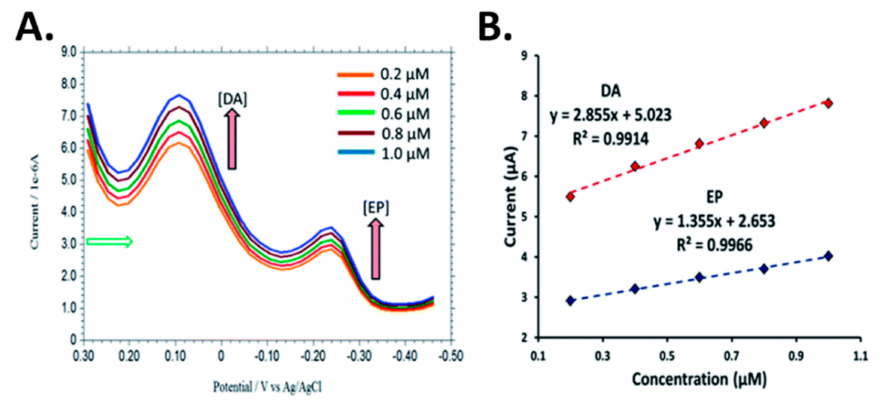
Figure 10. ( A ) DPV voltammograms of increasing concentrations of DA and EP in 0.1 M PBS at AgNPs-PCA-Au electrode. ( B ) Plot of current as a function of concentration of DA and EP. Reprinted with permission